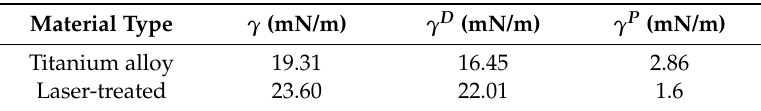
Table 6. Surface free energies of titanium alloy.